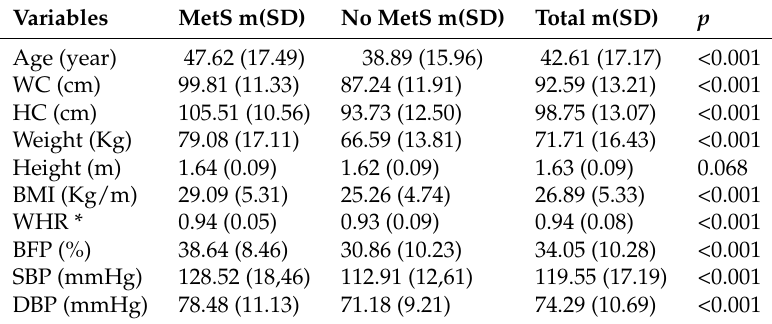
Table 8. Statistical description of the study variables for the total